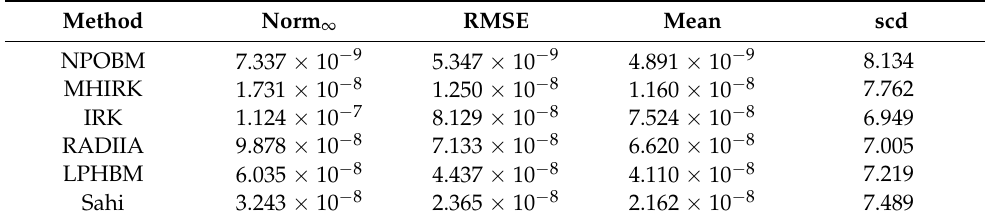
Table 9. Numerical results for Problem 3 with NS = 2 6 where x ∈ [ 0,5 ] .